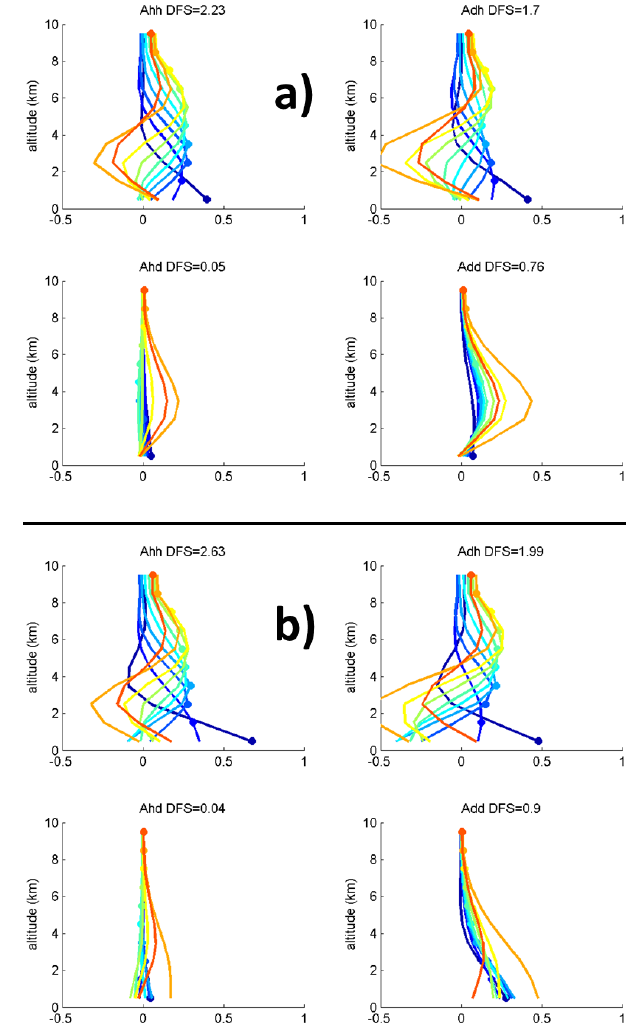
Figure 4. Monthly Jacobian means of H 2 O (upper panel) and HDO (bottom panel) as a function of altitude and wave number for July 2011 with a low ( < 4K) (a) and a large ( > 8K) (b) absolute value of thermal contrast. The smallest derivative values indicate the maximum sensitivities (dark blue). As in Fig. 2, the gap high- lights the part where the retrieval is not performed, avoiding major CH 4 and N 2 O interferences.